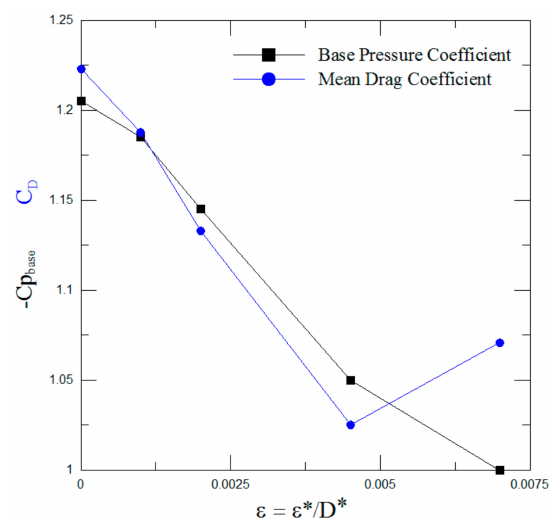
Figure 10. Comparison between computed results of base pressure and mean drag coe ffi cients (Re = 1.0 × 10 5